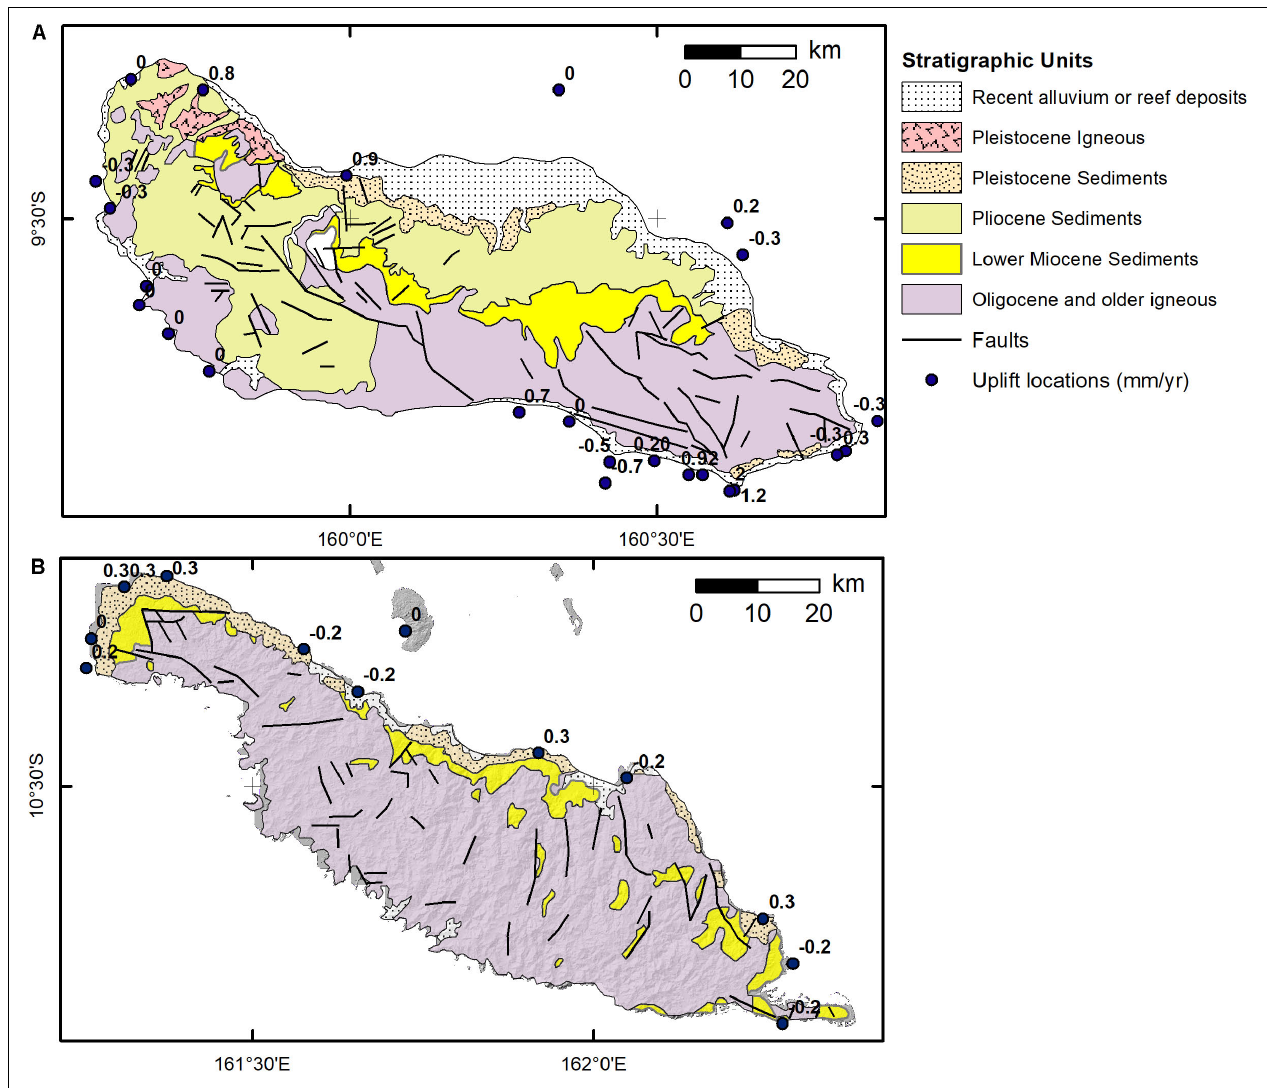
FIGURE 2 | Geological maps [simplified from Department of Geological Surveys (1969)] of (A) Guadalcanal and (B) Makira showing mapped faults and uplifted coral reef locations used to interpolate the uplift field (Chen et al.,